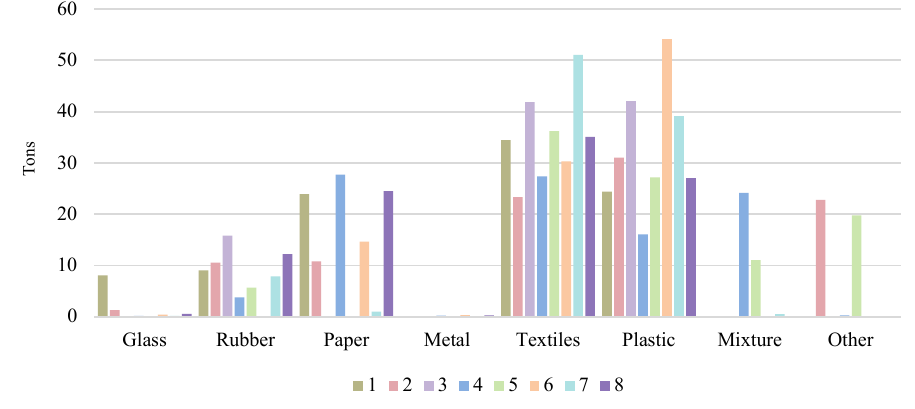
Fig. 2. Healthcare waste by waste material from different healthcare facilities, data were obtained from the research conducted within the project.